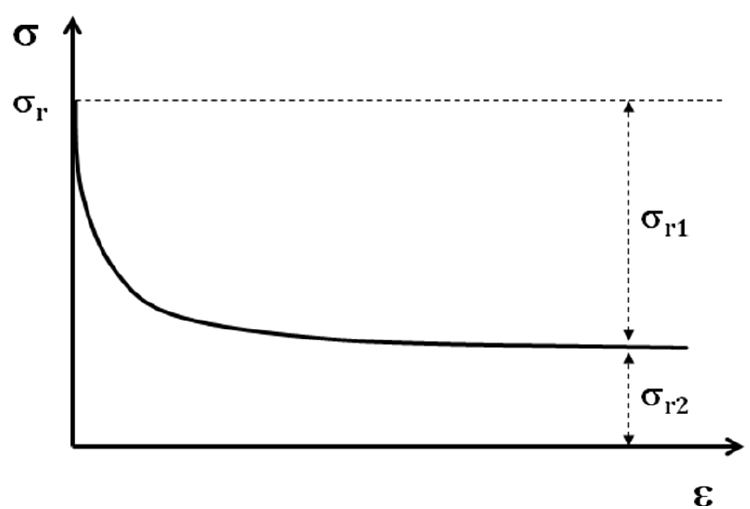
Figure 11. Schematic relaxation